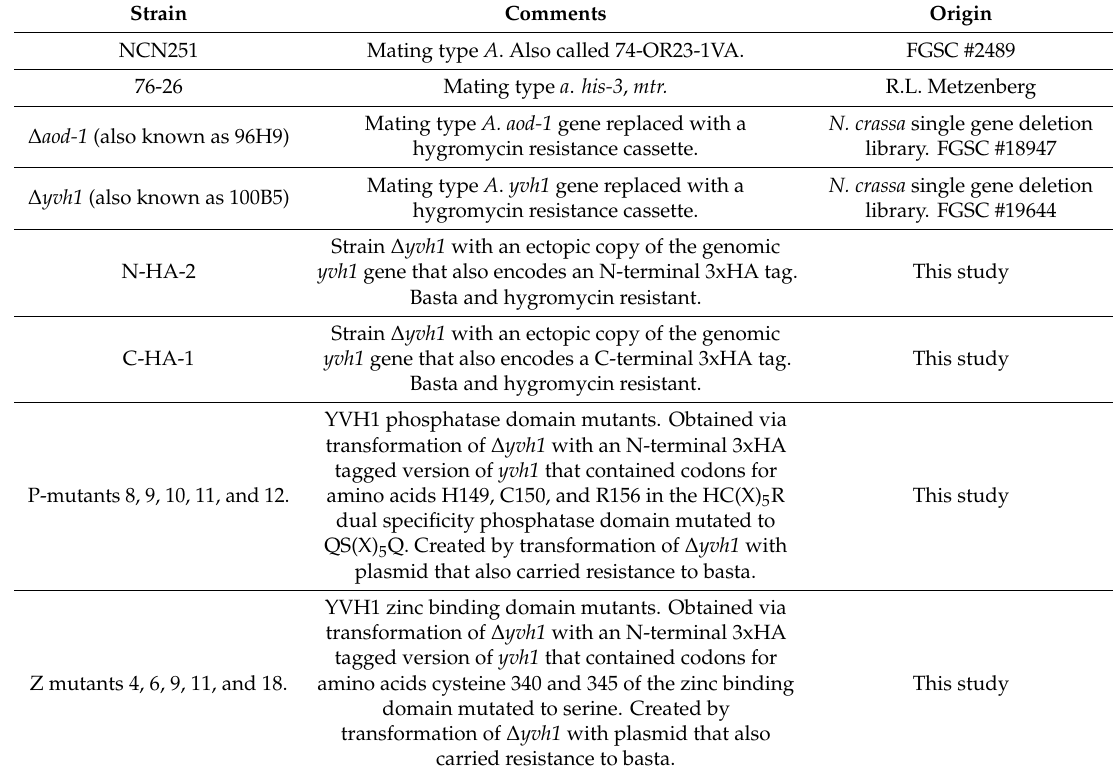
Table 1. Strains used in this